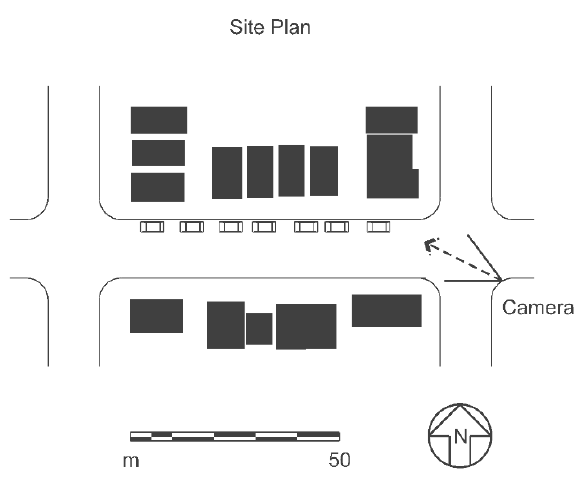
Figure 5. Site plan for car vs . no car.